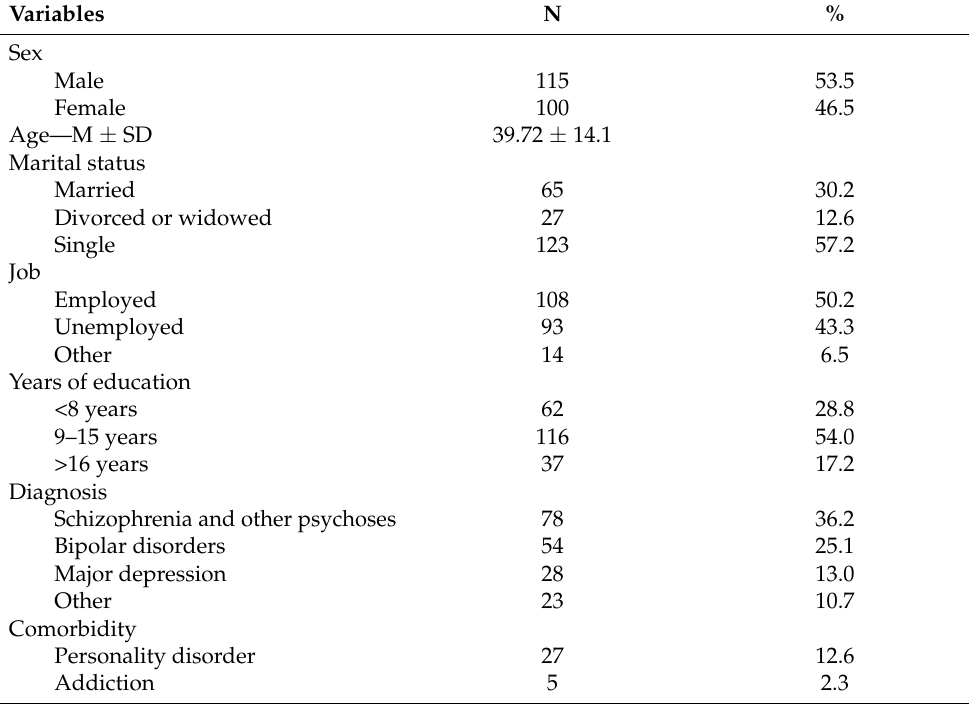
Table 1. Sociodemographic and clinical characteristics of the sample (N =